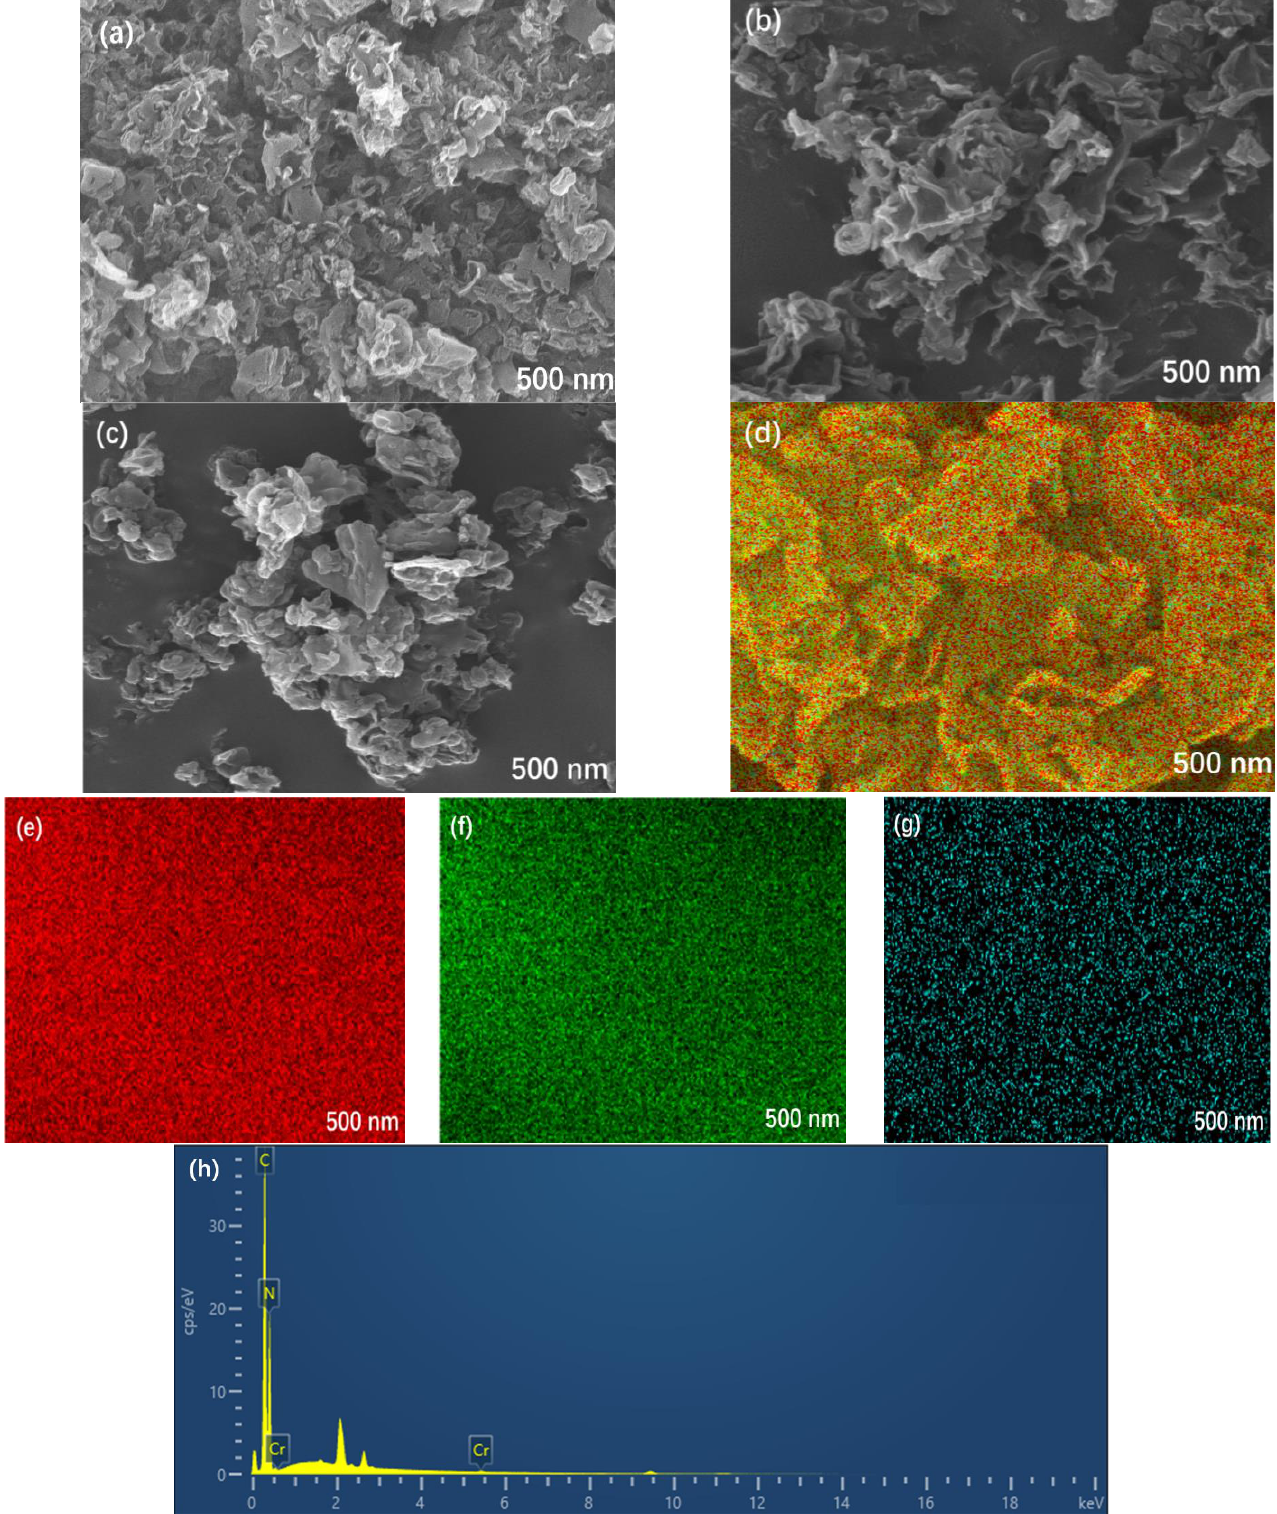
Figure 2. SEM images of ( a ) g-C 3 N 4 , ( b ) CA-g-C 3 N 4 and ( c ) after the reaction of CA-g-C 3 N 4 . EDS element mapping ( d – h ) of after the reaction of CA-g-C 3 N 4 .